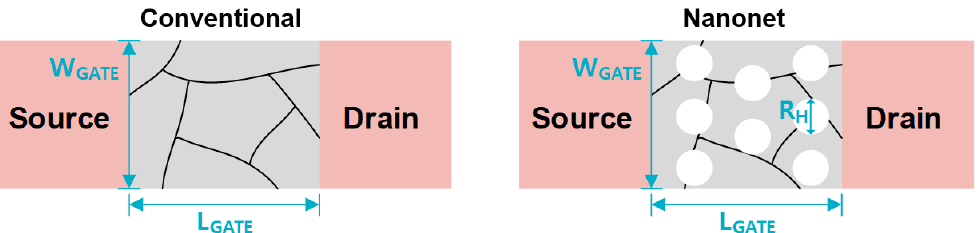
Figure 3. Top SEM images of ( a ) spin coated nanosphere after Figure 1c and ( b ) nanonet-channel after Figure 1g. Figure 4. Top-view scheme of conventional planar TFTs (CON_TFTs) ( left ) and nanonet-channel low-temperature polysilicon TFTs (NET_TFTs) ( right ).